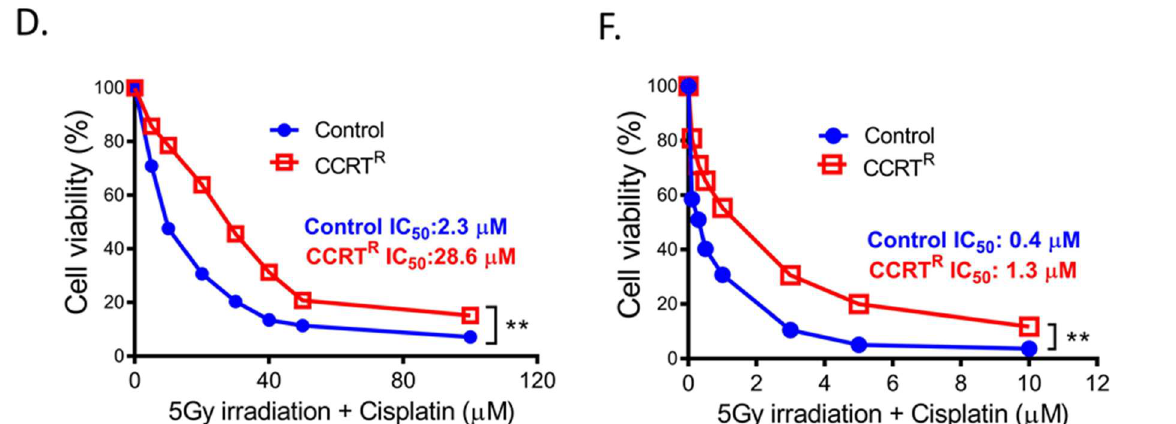
Figure 1. Establish acquired concurrent chemoradiotherapy resistance (CCRTR) ESCC cell lines and validate their viability to CCRT treatment. ( A ) A schematic diagram of two chemoradioresistant ESCC cell lines (CE48T and Kyse70) established by fractionated irradiation (5 Gy) and cisplatin treatment. Total effective dosage of irradiation exposure was 65–75 Gy. ( B ) Cell viability was examined in CCRT-selected CE48T cells. Different CCRT intensity-selected CE48T cells (5th, 10th and 15th) and control cells were treated with the indicated CCRT conditions, 5 Gy irradiation and various concentrations of cisplatin (0, 5, 10, 20, 30, 40, 50 and 100 µ M) to determine their CCRT response by MTT assay. These three independent cell lines harbored a consistent resistance potential but differential resistance ability to CCRT treatment. ( C ) Validation of chemoradioresistant ability in acquired CE48T CCRT-resistance line (CCRTR) by colony formation assay. CE48T parental control and CCRTR cells were treated with the combination of 5 Gy irradiation exposure and indicated concentrations of cisplatin (0, 5, 10, 20, 30, 40 µ M). At the end of 12 days incubation period, viable cell colonies were fixed, stained with crystal violet, and calculated. Upper panel: Representative images of viable colonies after CCRT treatment; lower panel: Quantification of CCRT-mediated colonies formation in control and CCRTR cells at 12 days post-CCRT treatment.( D ) Examine the effect of CCRT treatment on cell viability using CE48T control and CCRTR cells by MTT assay. The 1 × 10 4 control and CCRTR cells were plated into a 96-well plate, cells were treated with 5 Gy irradiation combined with the indicated concentrations of cisplatin (0, 5, 10, 20, 30, 40, 50, and 100 µ M) for 48 h. Relative quantification of cell viability in control and CCRTR cells post 48h-CCRT treatment compared to cells without CCRT treatment were shown. The IC50 to cisplatin is 2.3 µ M in control cells and 28.6 µ M in CCRTR cells. ( E ) Validation of Chemoradioresistant ability in acquired Kyse70 CCRT-resistance line (CCRTR) by colony formation assay. Experimental protocol was similar to (C), whereas the treatment concentrations of cisplatin were 0, 0.1, 0.3, 0.5, 1, and 5 µ M. Representative images of viable colonies at 14 days post-CCRT treatment (top) and quantification of CCRT-mediated colonies formation in control and CCRTR cells (bottom) were shown. ( F ) Examine the effect of CCRT treatment on cell viability using Kyse70 control and CCRTR cells by MTT assay. The 1 × 10 4 control and CCRTR cells were plated into a 96-well plate, cells were treated with 5 Gy irradiation combined with the indicated concentrations of cisplatin